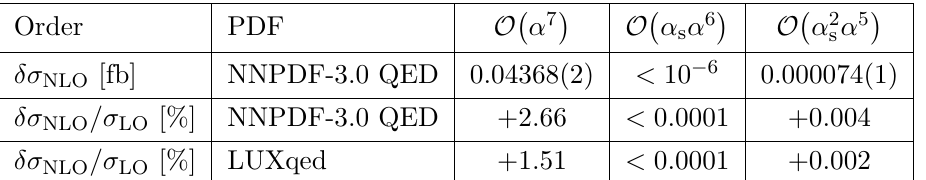
(cid:22) + (cid:23) (cid:22) e + (cid:23) e jj at the orders !